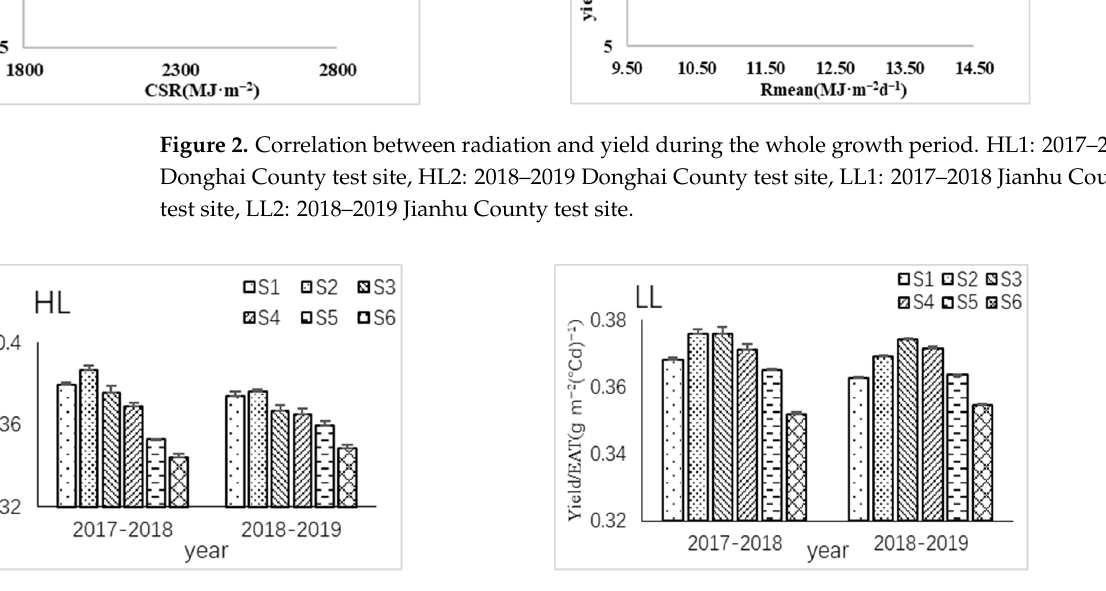
Figure 3. The ratio of yield to effective accumulative temperature at two latitudes in 2017–2018 and 2018–2019. S1, S2, S3, S4, S5 and S6 represent the sowing dates of 31October, 10 November, 20 November, 30 November, 10 December and 20 December, respectively. HL: Donghai County test site, LL: Jianhu County test site. The vertical strip represents the standard error of the average value of the two varieties (nasty 2).